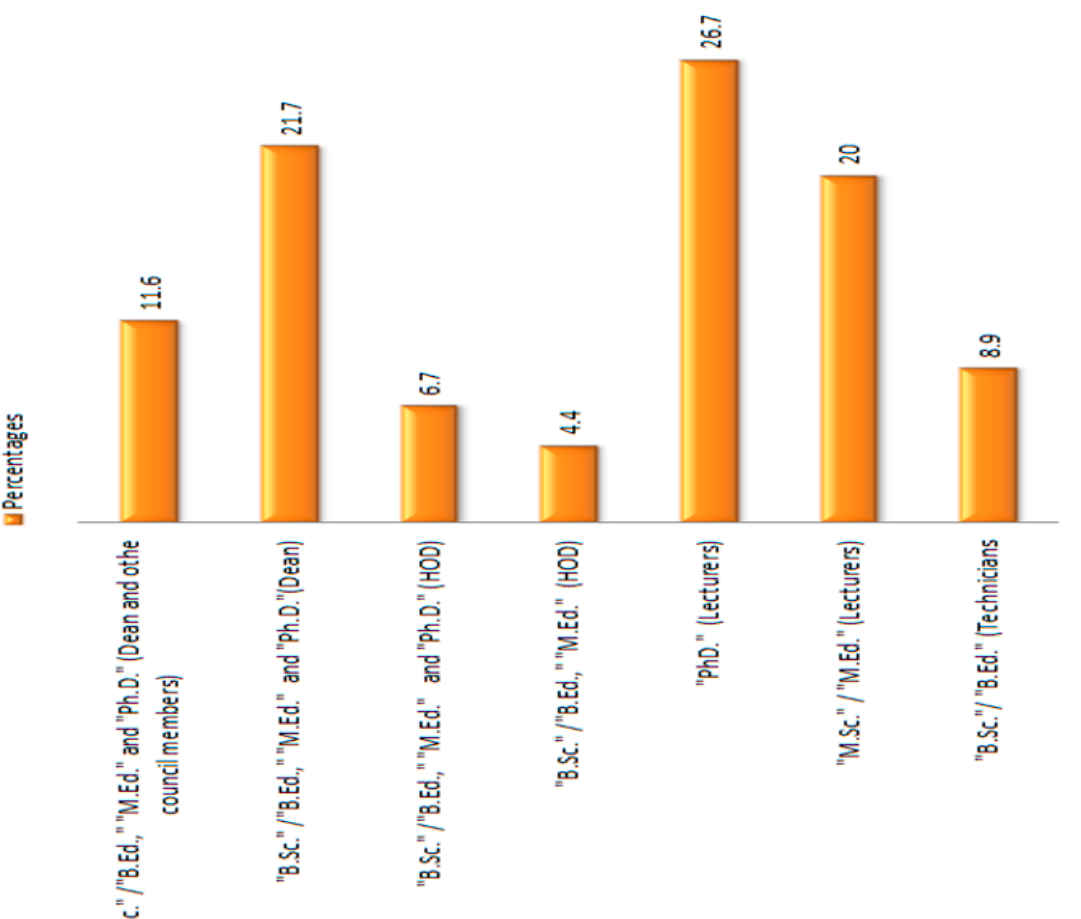
Figure 1. Educational background of administrators and other technical personnel. Table 2. Tools and strategies for effective e-learning Implementation. S/N Tools Used, Strategies and